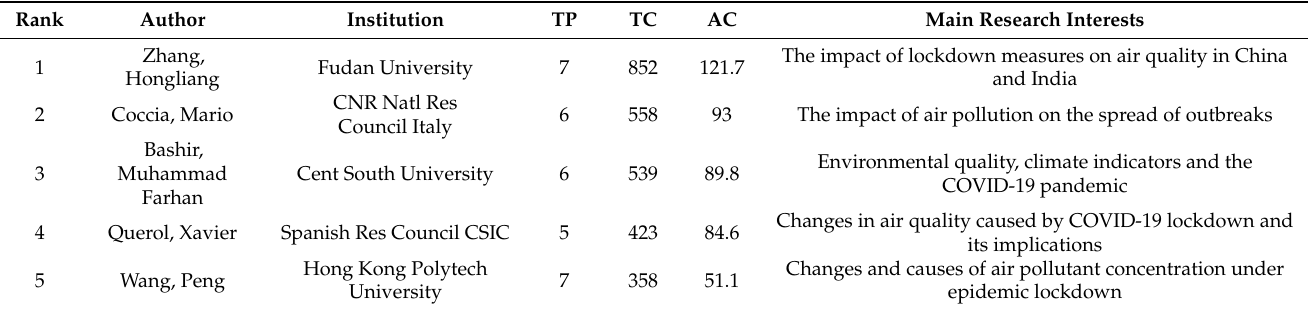
Table 1. Top 5 most productive authors on COVID-19 and air environment